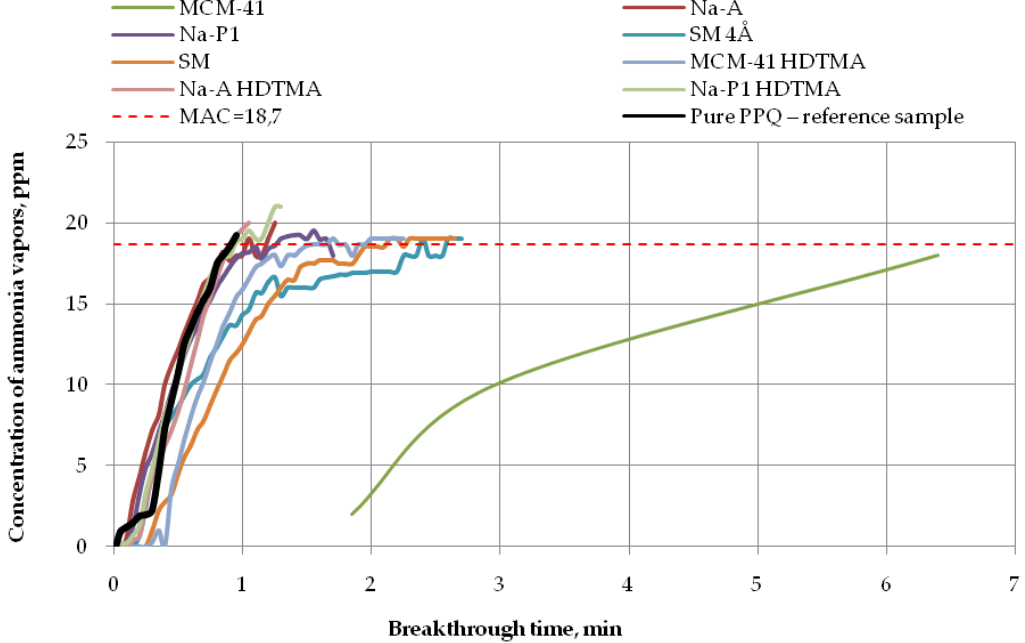
Figure 7. Breakthrough time for nonwoven zeolite and silica composites challenged with ammonia at MAC = 18.7 ppm.